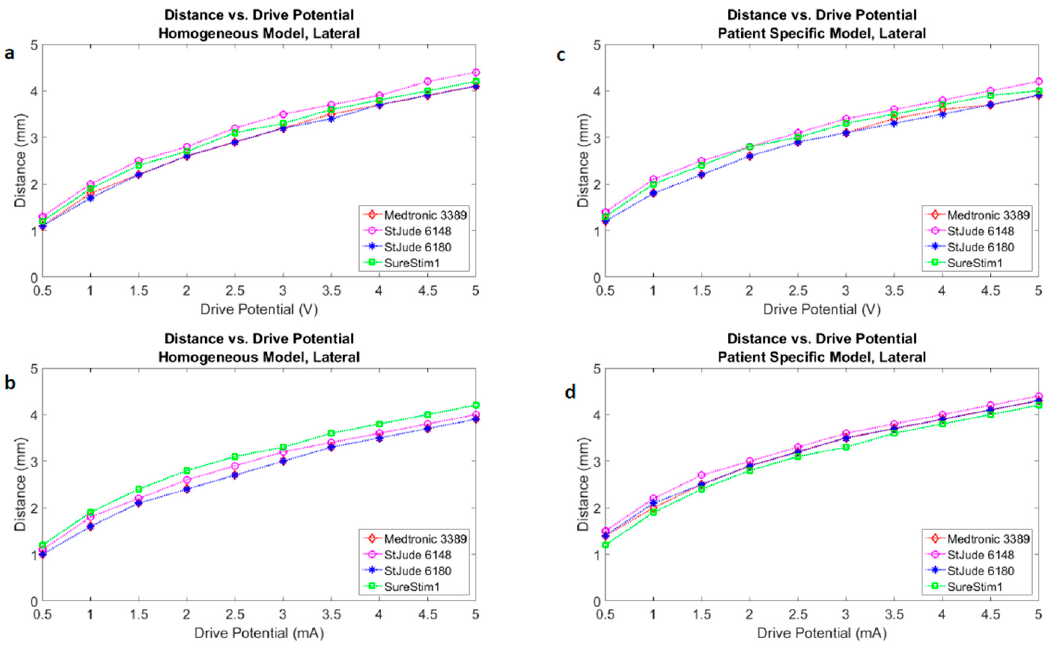
Figure A2. Neuron modelling: Distance vs. drive potential. Lateral.